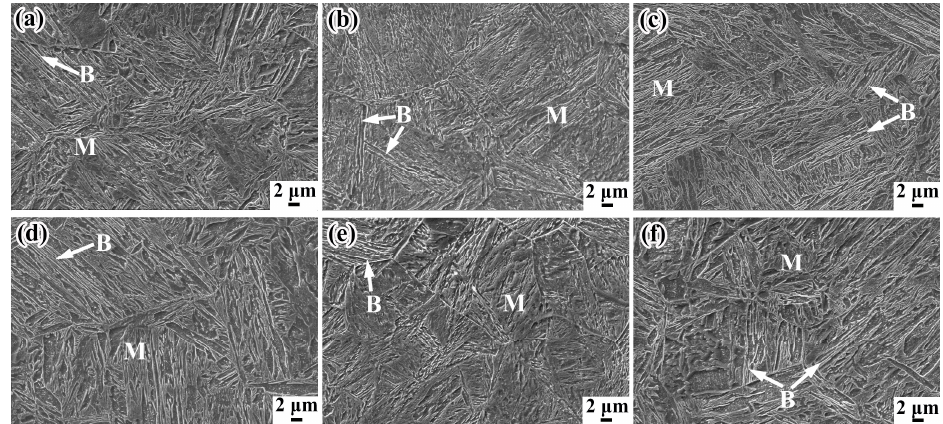
Figure 3. Scanning electron microscopy (SEM) of samples at the positions of 5 mm and 15 mm below rail tread treated by di ff erent process: ( a ) T230-P5; ( b ) T250-P5; ( c ) T280-P5; ( d ) T230-P15; ( e ) T250-P15; ( f ) T280-P15.